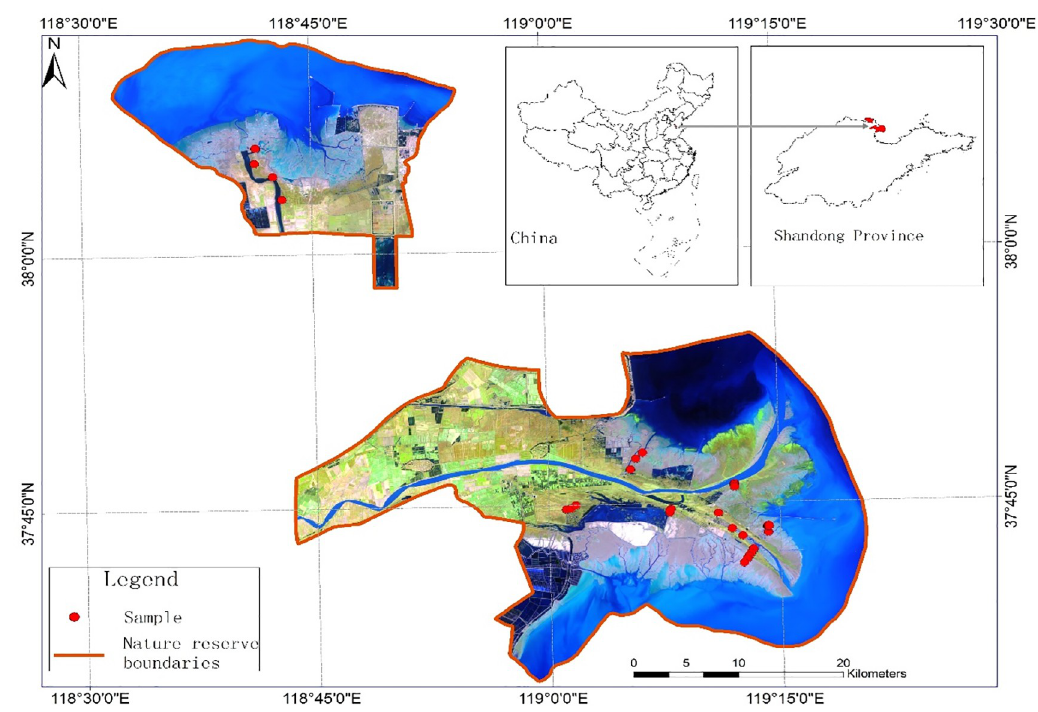
Fig 1. The Yellow River Delta Nature Reserve and samples taken for the study of wetland